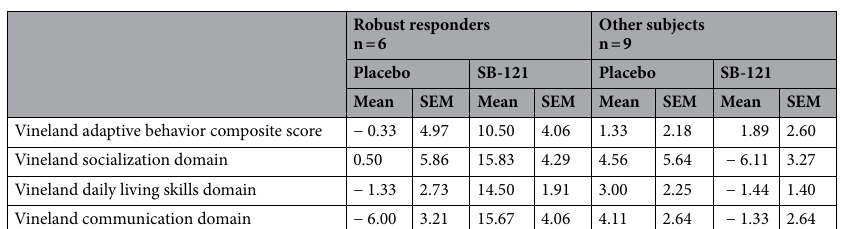
Table 5. Vineland-3 robust responders and other subjects (change from baseline). SEM standard error of the mean.